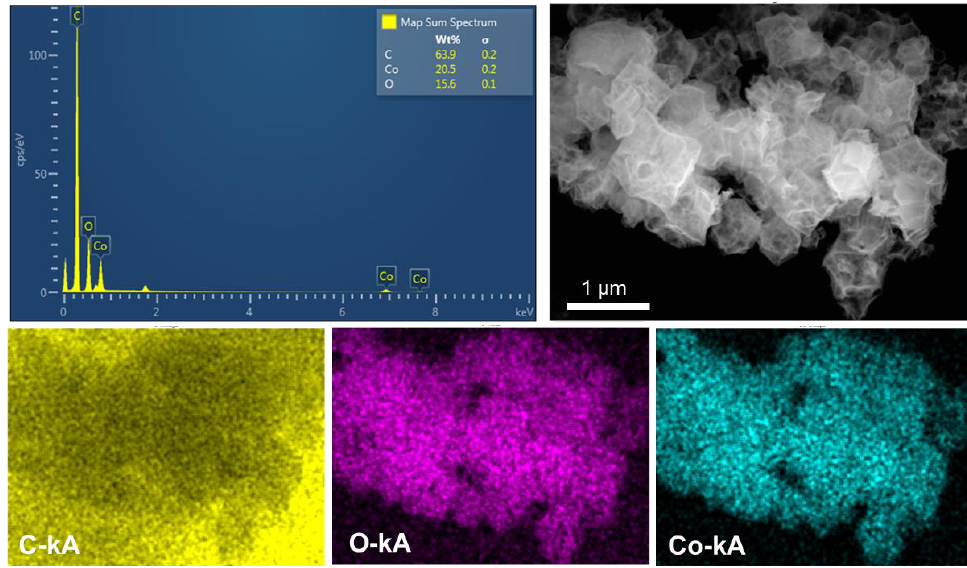
Figure 2. ( a , b ) TEM diagrams at different magnifications of MWCNT 3 @Co 3 O 4 ; ( c , d ) high-resolution transmission electron microscopy (HRTEM) and selected area electron diffraction (SAED) of MWCNT 3 @Co 3 O 4 .